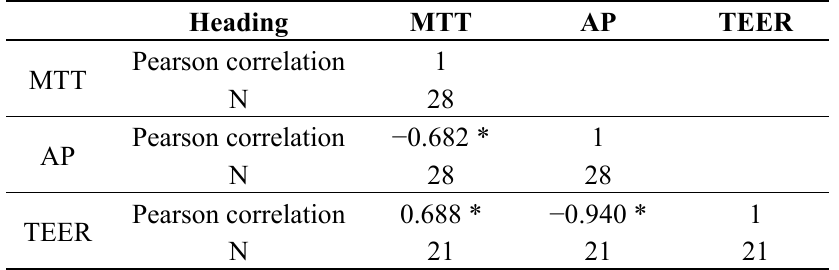
Table 1. Pearson correlations between two of the experimental indicators (MTT, AP, and TEER values) after treatment with different concentrations of SBA for 72 h. Pearson correlations were obtained using SPSS 17.0 software. Heading MTT